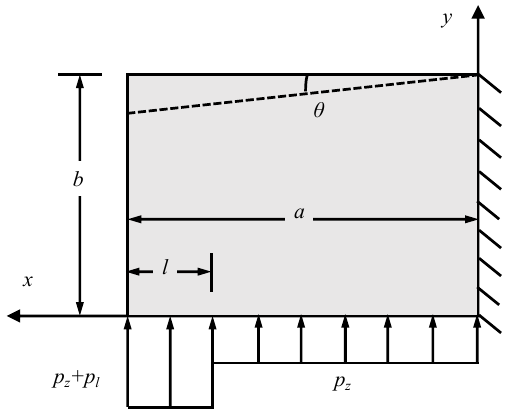
Figure 3. Mechanical model of the short cantilever beam.